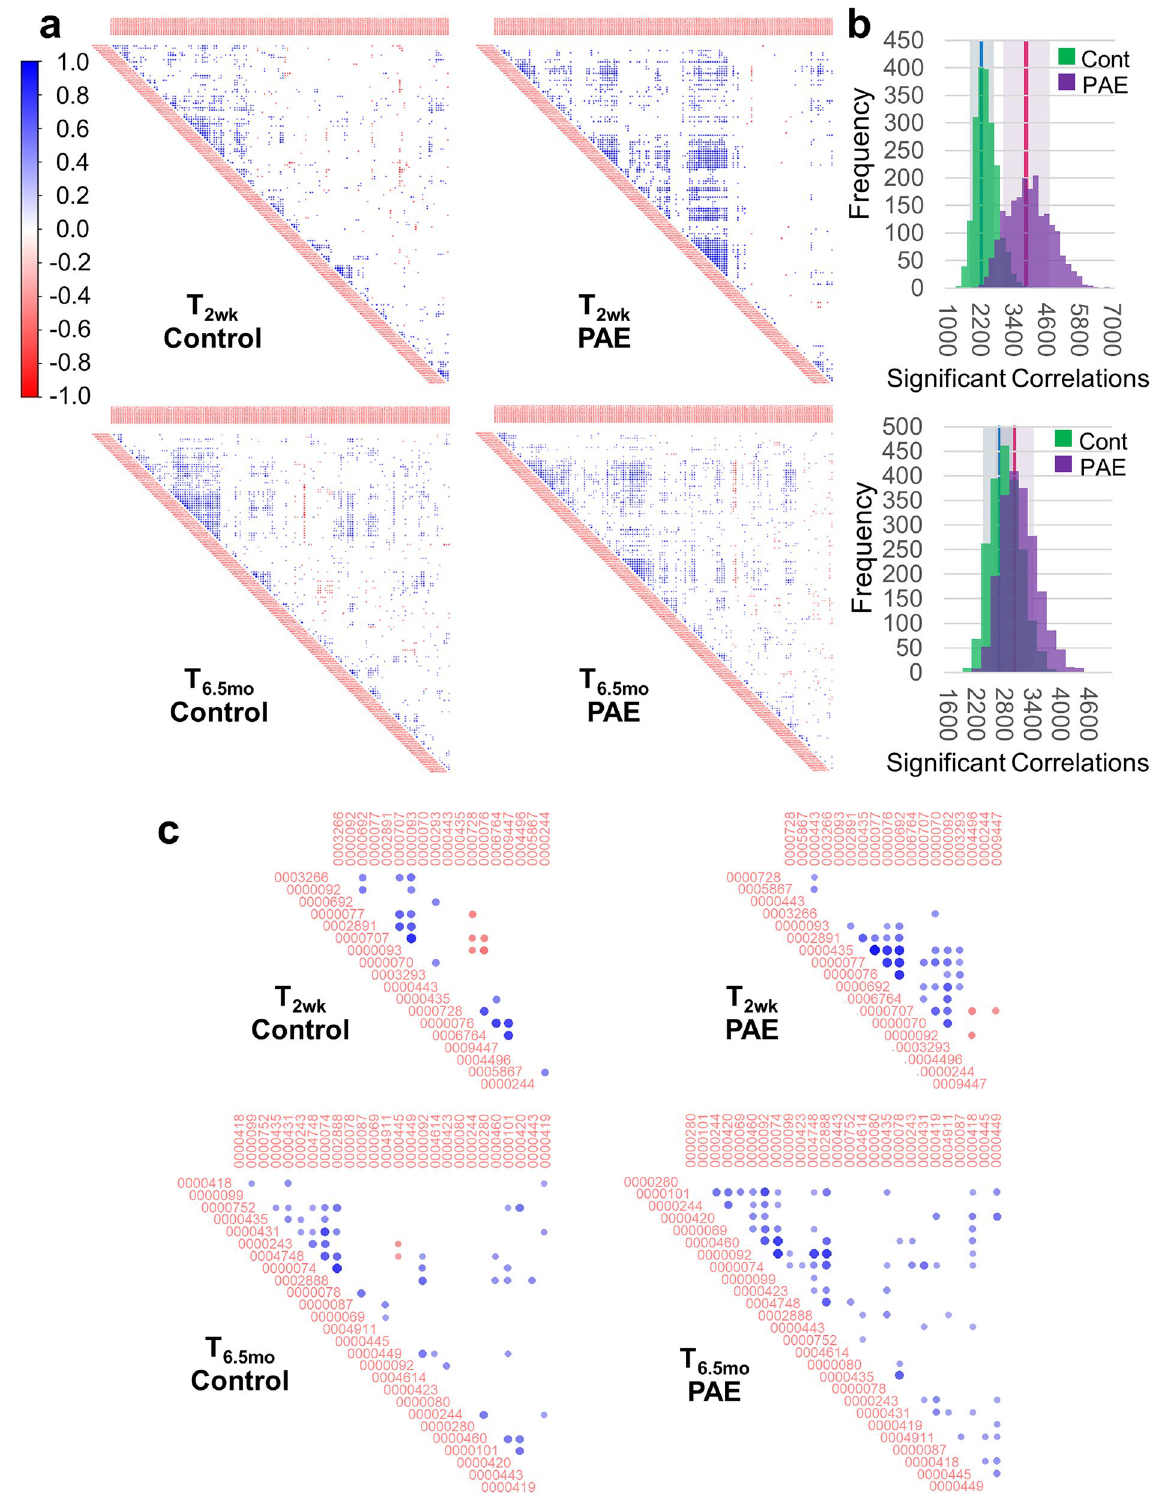
Figure 4. ex miRNAs are highly correlated in PAE infants at T 2wk . ( a ) Hierarchically clustered correlation plots of significant ( p < 0.05) ex miRNA cross correlations. ( b ) Bootstrap resampling to assess the stability of the number of correlations at T 2wk (top)and T 6.5mo (bottom). The standard deviation of each distribution are shown by the shaded regions and 99% confidence intervals are shown by the blue (control) and pink (PAE) regions. ( c ) Hierarchically clustered correlation plots of significant ( p < 0.05) ex miRNA cross correlations for ex miRNAs with an effect size ≥ 0.40. Figures ( a ) and ( c ) were constructed using the corrplot package (version 0.77, https ://cran.r- proje ct.org/web/packa ges/corrp lot/index .html) for R (version 3.6.1) and figure (b) was constructed using